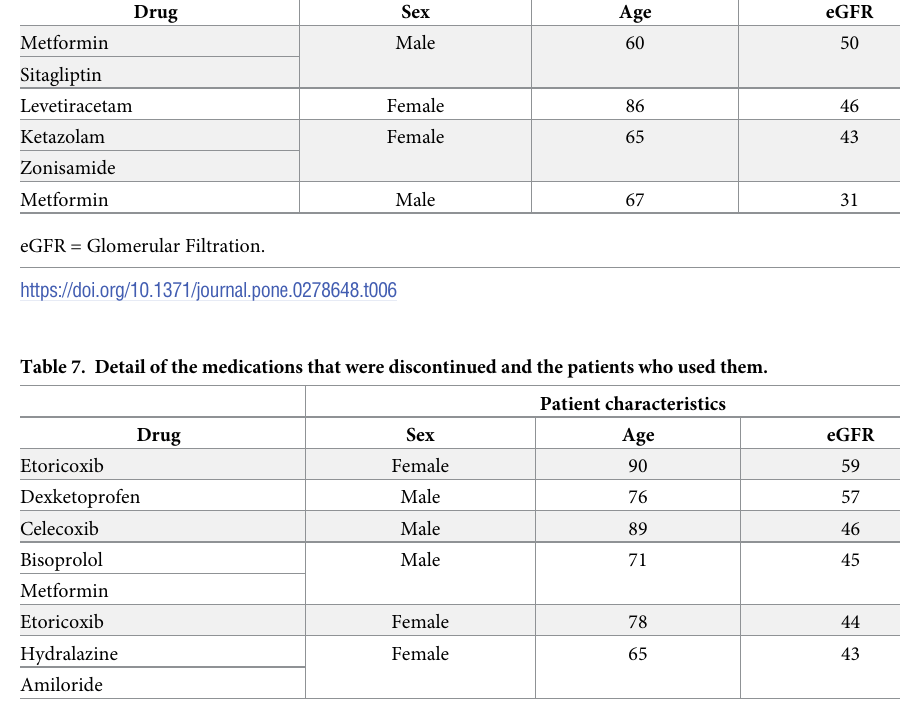
eGFR = Glomerular Filtration.